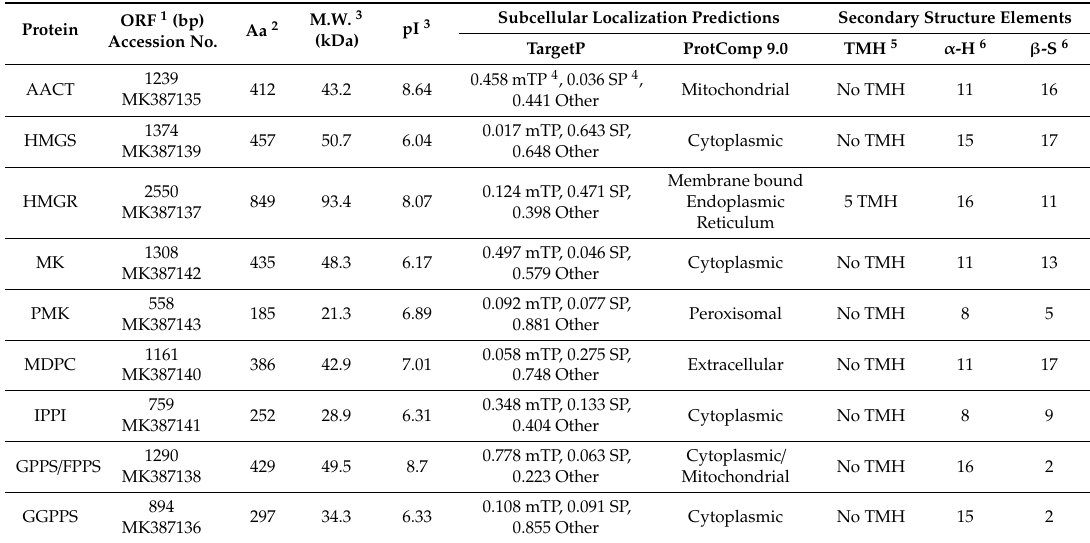
Table 2. Physicochemical properties, cellular localization, and secondary structure elements predicted for D . rhizophagus MVA pathway’s putative